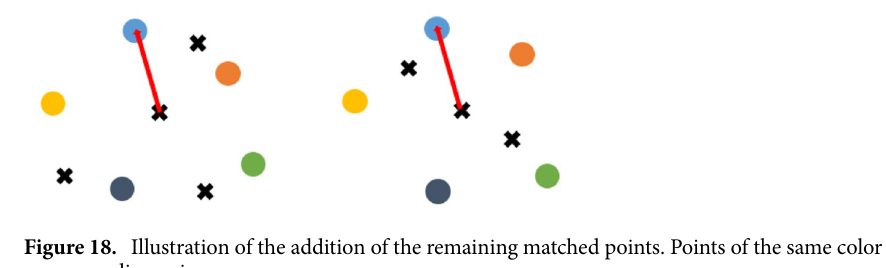
Figure 18. Illustration of the addition of the remaining matched points. Points of the same color are corresponding